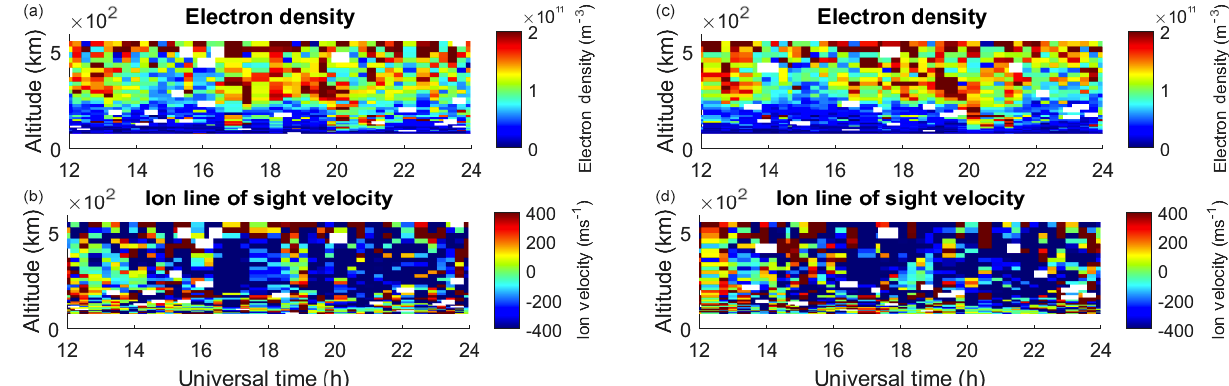
Figure 10. Electron densities and ion drift line of sight velocities observed by the 32m dish of the ESR at − 43 ◦ azimuth and 30 ◦ elevation (a, b) and at − 14 ◦ azimuth and 30 ◦ elevation (c, d) between 12:00 and 23:59UT on 10 December